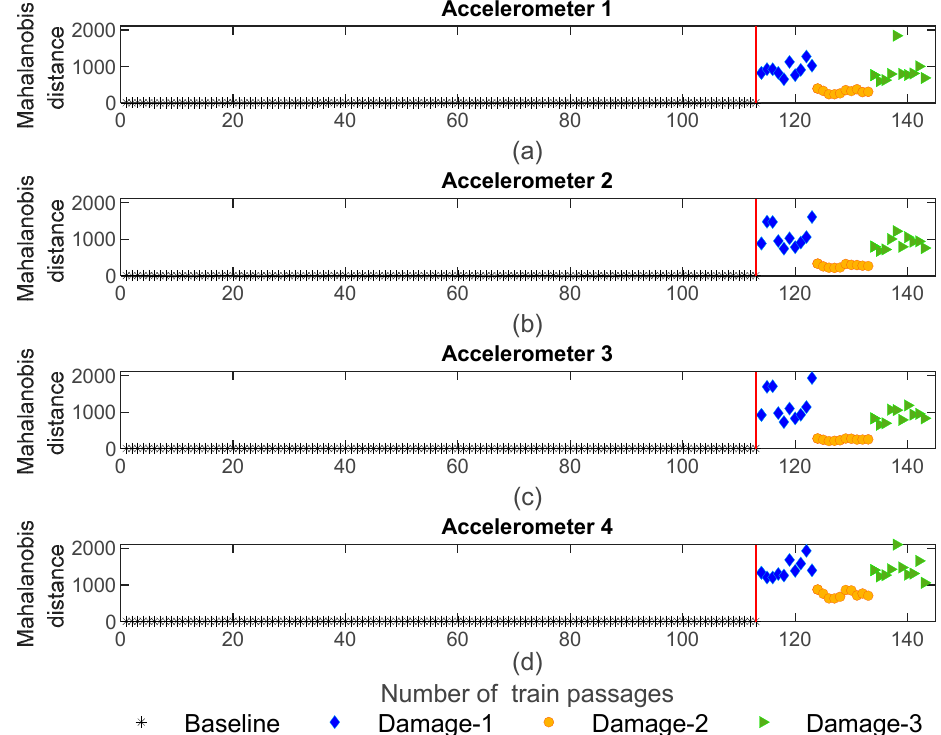
Figure 16. AR—data fusion for all 143 baseline and damage scenarios: ( a ) MD for accelerometer 1, ( b ) MD for accelerometer 2, ( c ) MD for accelerometer 3, ( d ) MD for accelerometer 4.